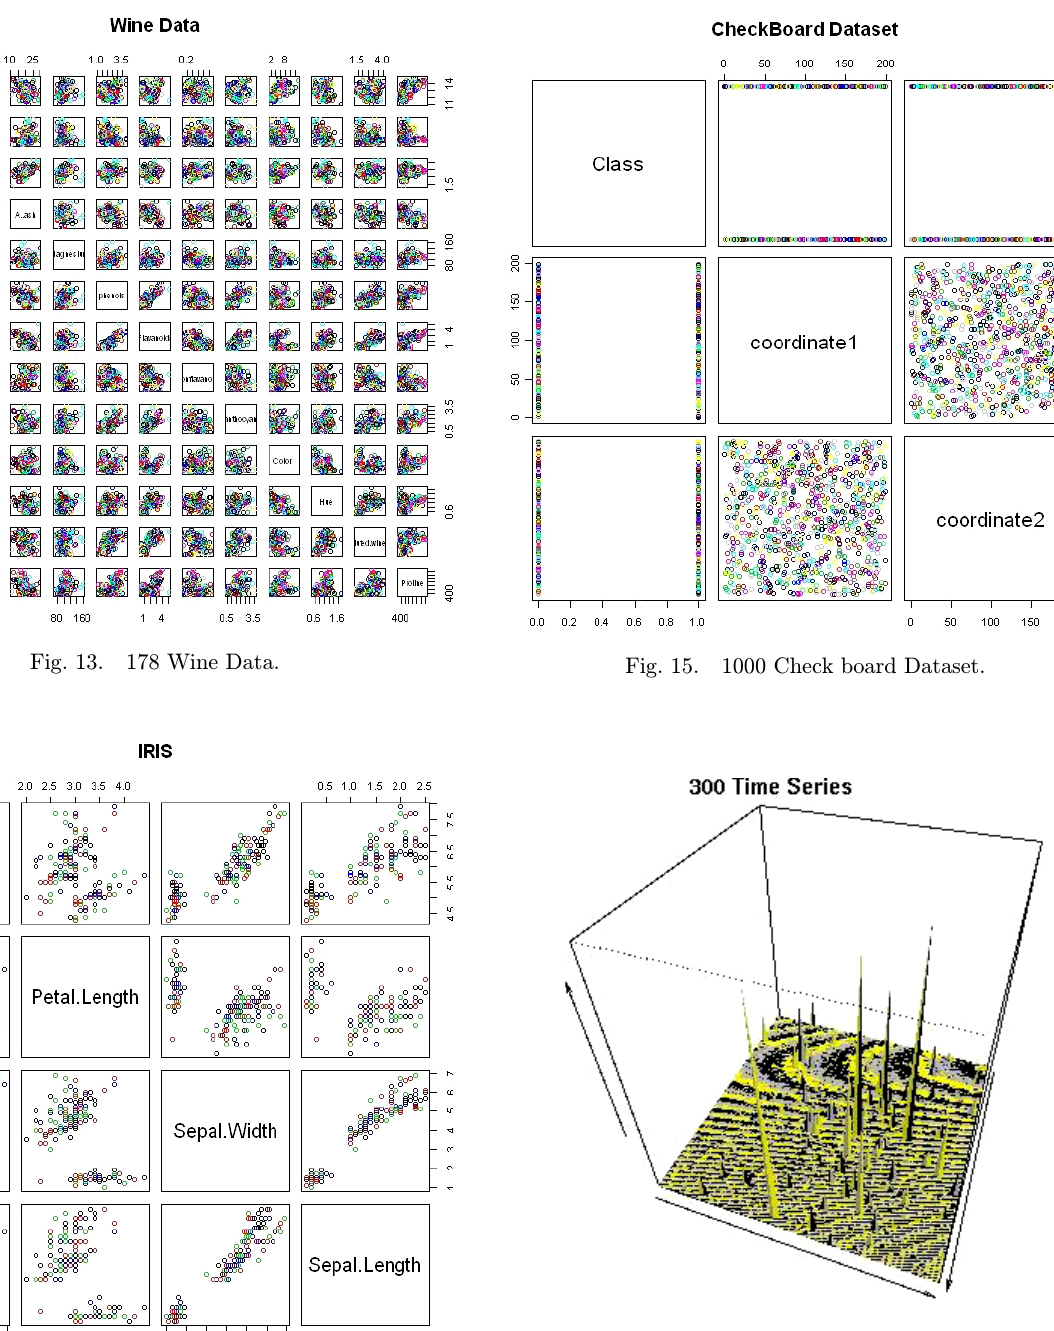
Fig. 16. 300 Time Series